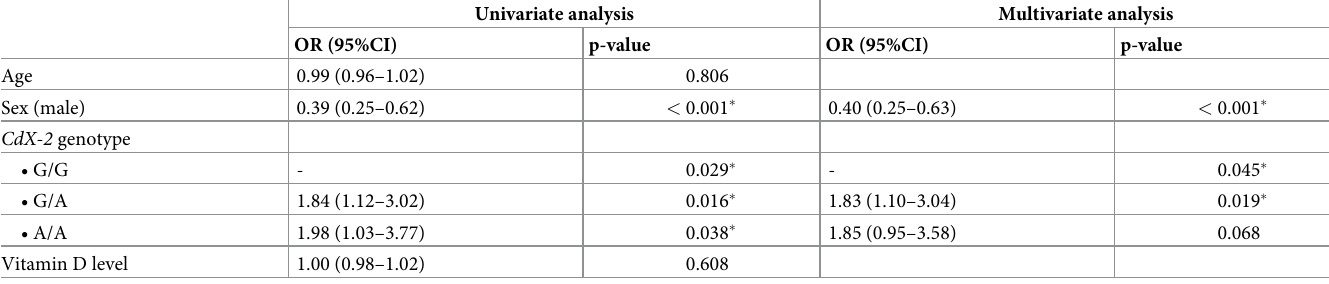
Table 5. Univariate and multivariate regression analysis of factors associated with HBV inactive carrier (IC)